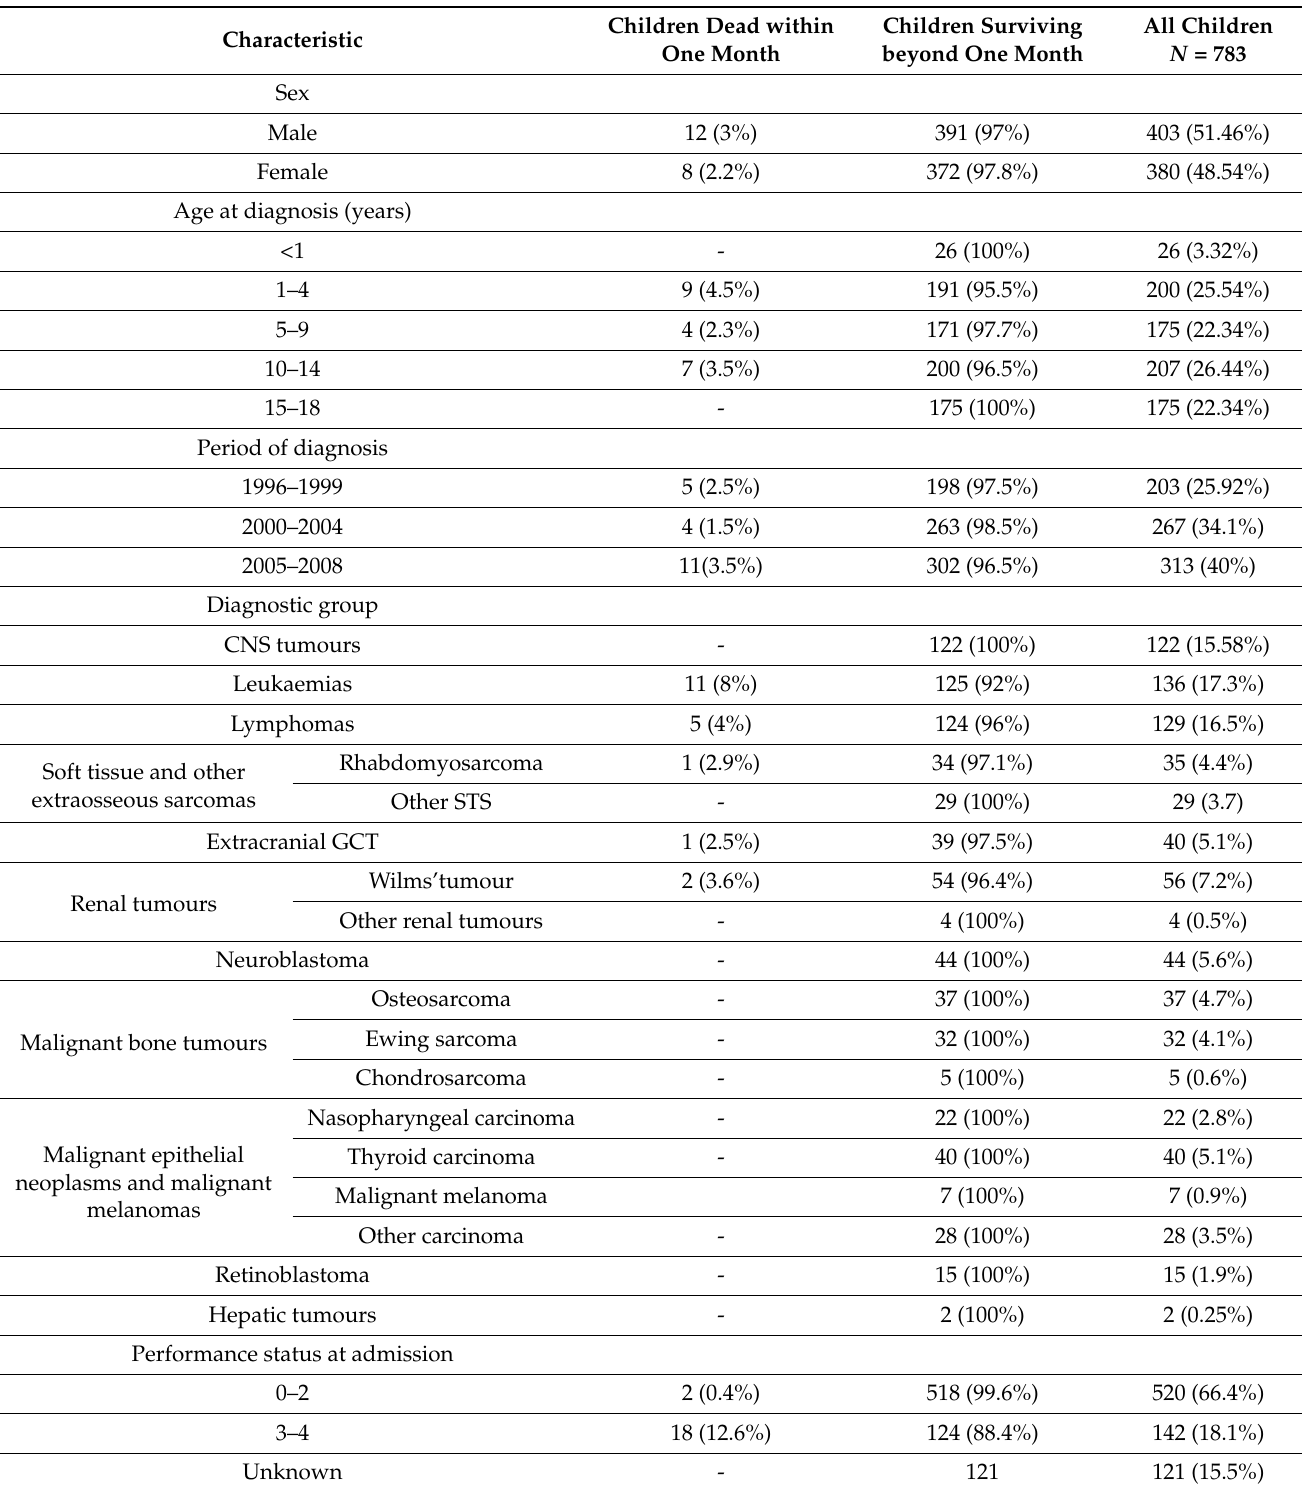
Table 1. Clinical and demographic characteristics of children with cancer who died within one month after diagnosis and of those surviving beyond that